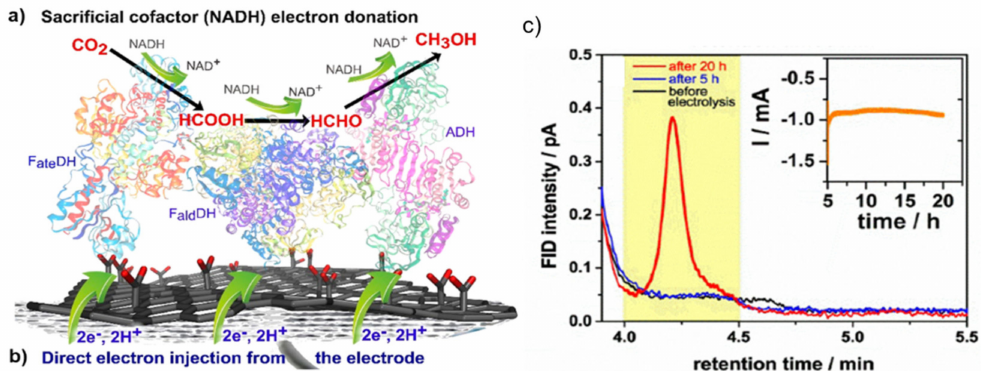
Figure 13. Multi-enzymatic cascade reduction of CO 2 to methanol. ( a ) NADH sacrificial cofactor approach; ( b )NADH-freeapproach; ( c )Faradaice ffi ciencyofthecascade. Figureadaptedfrom Ref.